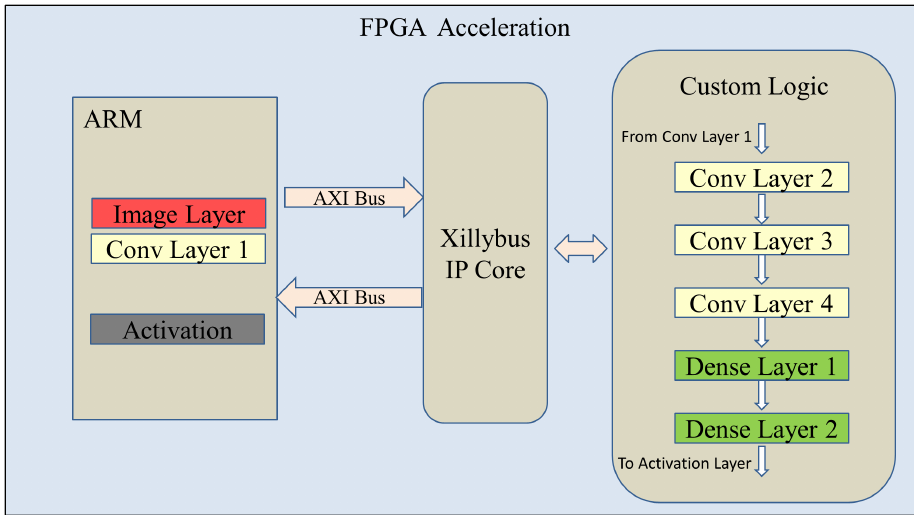
Figure 3. Field Programmable Gate Array (FPGA) acceleration